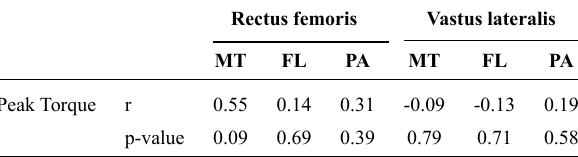
Table 2 - Relationship between normalized torque and muscle archi-